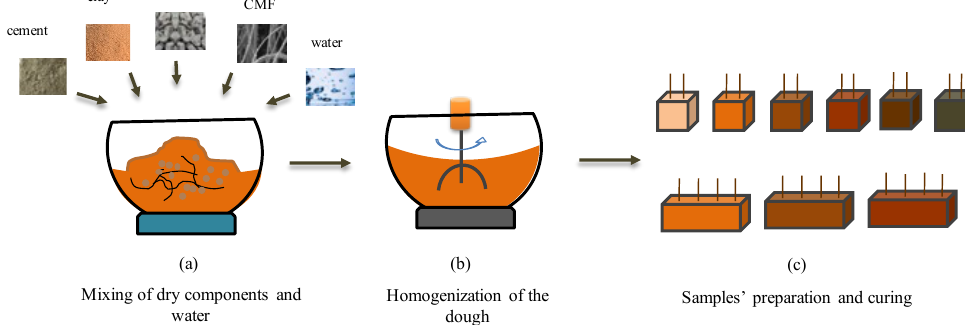
Figure 1. The manufacturing steps for smart earth samples: ( a ) addition of ingredients inside mixing bowl; ( b ) mixing of the compound until the homogeneity of the composite dough; ( c ) preparation of small cube and medium-size beam samples from the composite dough, together with the placement of copper electrodes.